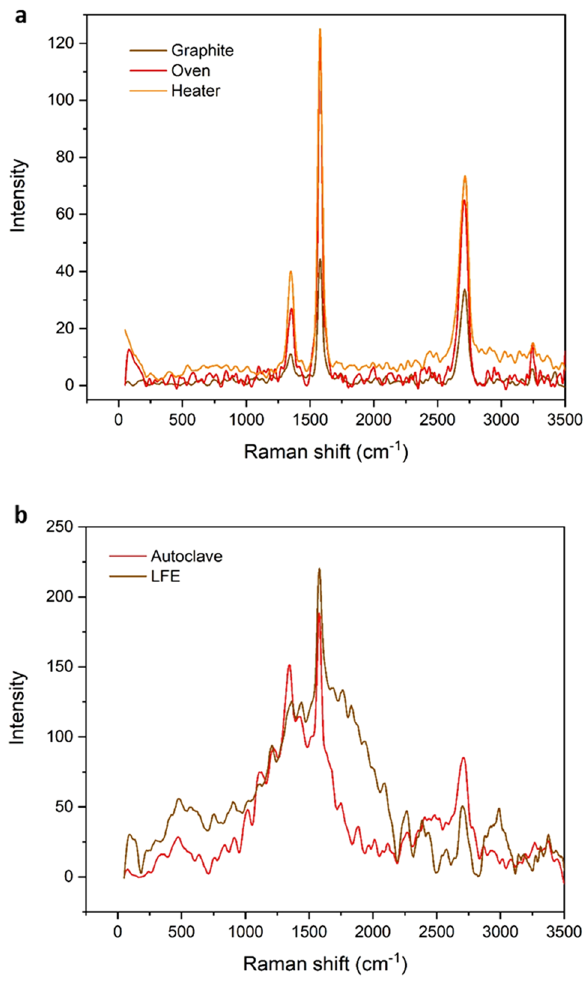
Figure 6. Vibrational modes of FGPs samples in Raman spectra. ( a ) Raman spectra of Graphite, Oven- , and Heater-method . ( b ) Raman spectra of Autoclave- and